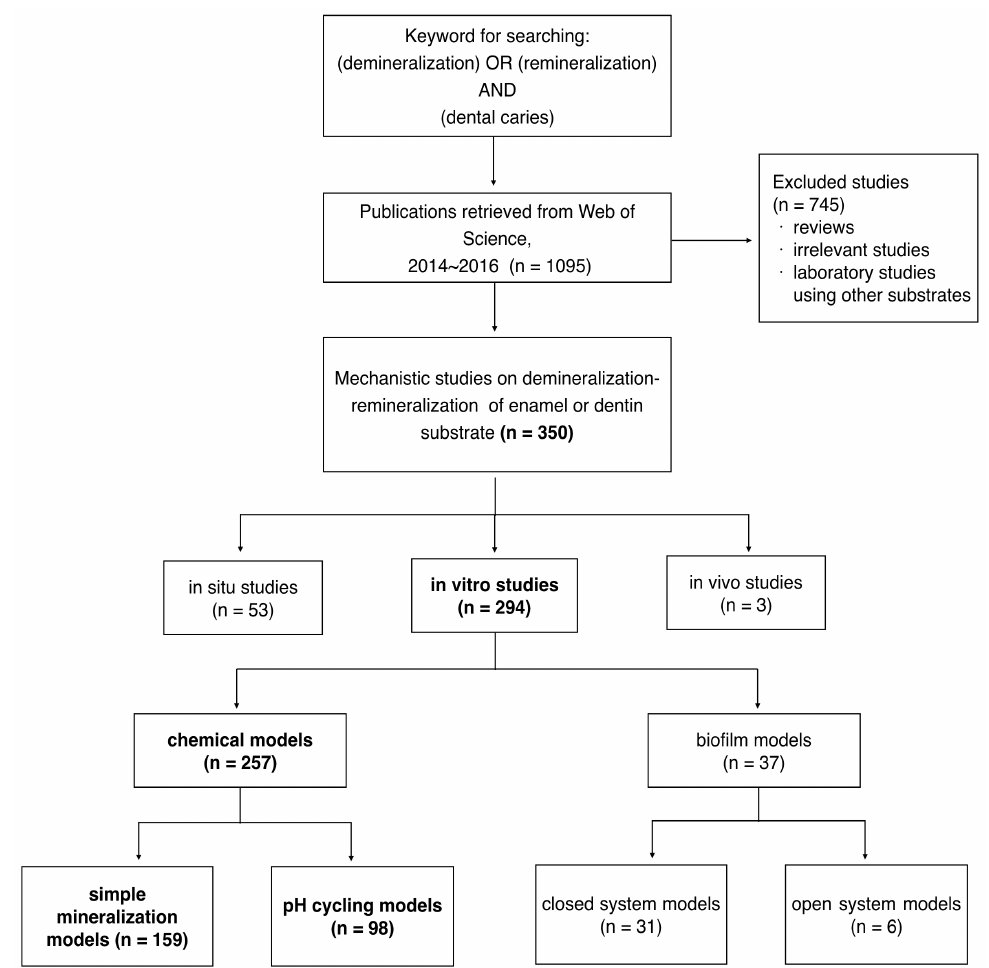
Figure 1. Mechanistic studies on demineralization-remineralization for cariology research published in Web of Science 2014–2016.